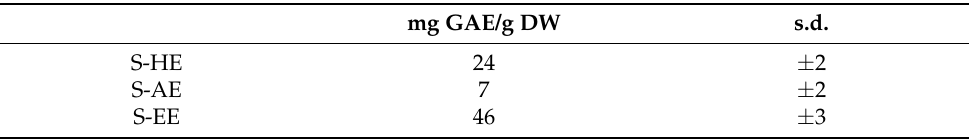
Table 1. Total phenolic content in S. ramosissima extracts. Results are expressed as mean ± standard deviation of five independent